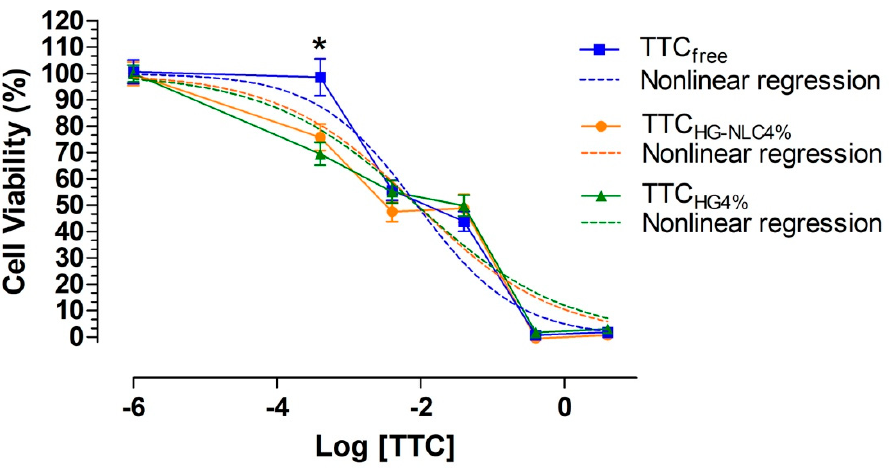
Figure 4. Effects of 4% TTC (TTC free ), TTC HG4% , and TTC NLC-HG4% on the viability of SH-SY5Y neuroblastoma cells (mean ± SEM, n = 3). Y -axis: cell viability in %, relative to the control group. X -axis: log of the drug concentration (%). The dotted lines show the nonlinear regression curves (log(inhibitor) vs. normalized response, variable slope). * Statistical differences between TTC HG and the other TTC formulations (using two-way ANOVA and the Bonferroni post-hoc test). In each experiment, the formulations were tested using nine wells for each concentration, at three different times.